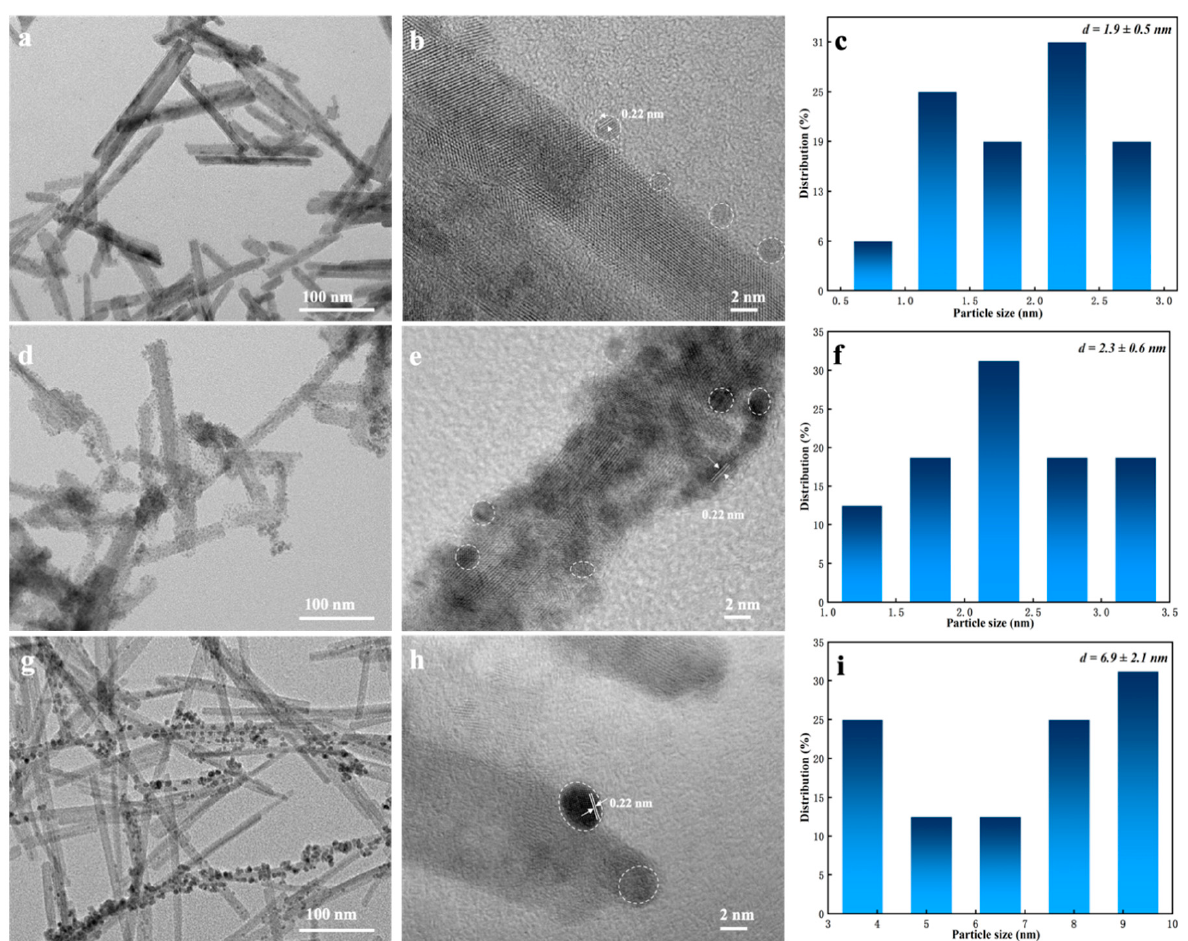
Figure 3. TEM, HRTEM images and Pd particle size distributions of ( a , b , c ) 0.3% Pd/CeO 2 -RE, ( d , e , f ) 0.5% Pd/CeO 2 -RE and ( g , h , i ) 1% Pd/CeO 2 -RE.